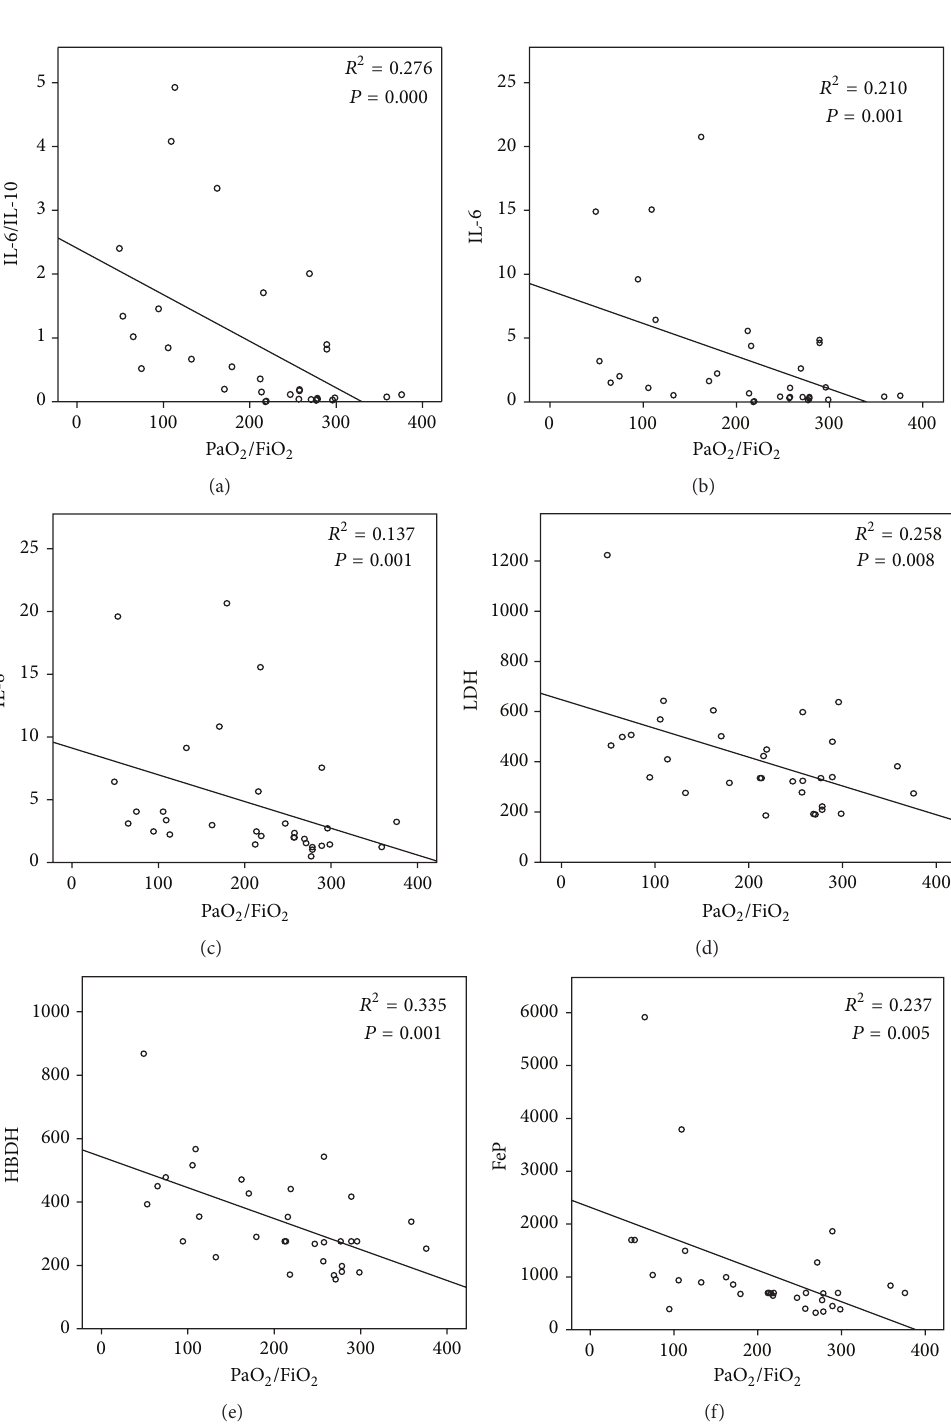
Figure 4: The correlation analysis of the oxygenation index with LDH, HBDH, FeP, IL-8, and IL-6 level and IL-6/IL-10 ratio. (a) IL-6/IL-10 ( 𝑃 = 0.000 , 𝑅 2 = 0.276 ); (b) IL-6 ( 𝑃 = 0.001 , 𝑅 2 = 0.210 ); (c) IL-8 ( 𝑃 = 0.001 , 𝑅 2 = 0.137 ); (d) LDH ( 𝑃 = 0.008 , 𝑅 2 = 0.258 ); (e) HBDH ( 𝑃 = 0.001 , 𝑅 2 = 0.335 ); and (f) Ferritin ( 𝑃 = 0.005 , 𝑅 2 = 0.237 ). which exerts negative regulatory effects on proinflammatory cytokines by downregulating their synthesis [31]. IL-10 is released in the lungs of experimental animals with PCP [32] and also in humans [33], resulting in decreased Pneumocystis - driven pulmonary inflammation and improved